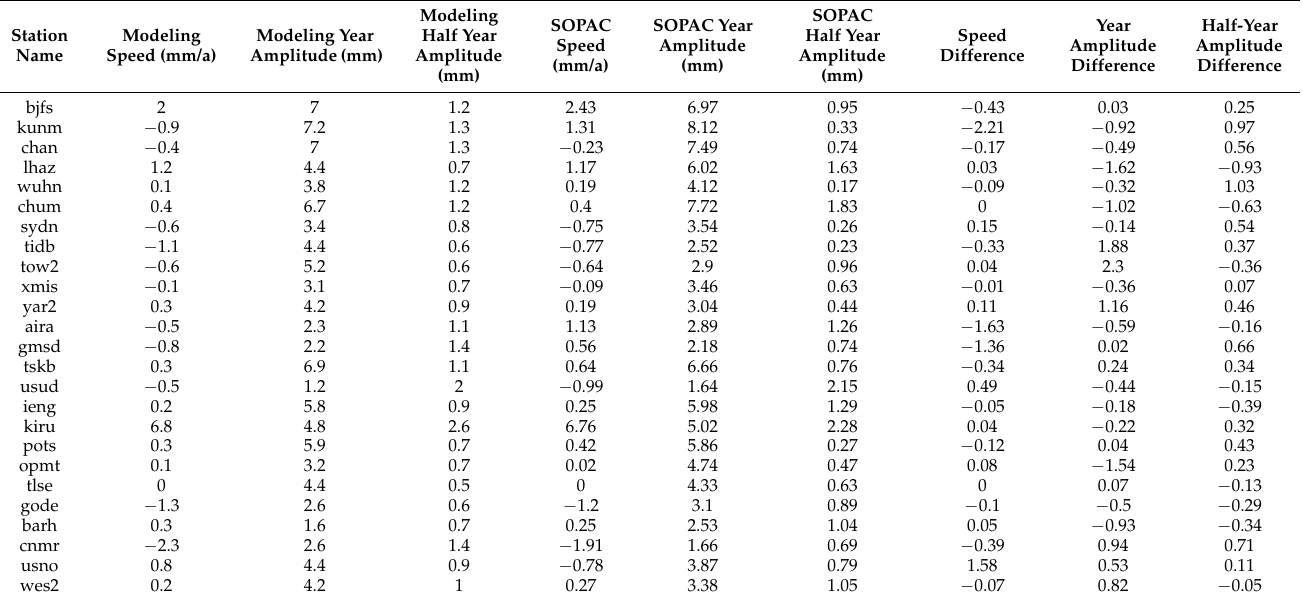
Table 6. Comparison of elevation nonlinear LS period modeling and SOPAC results for 25 CORS stations around the world.